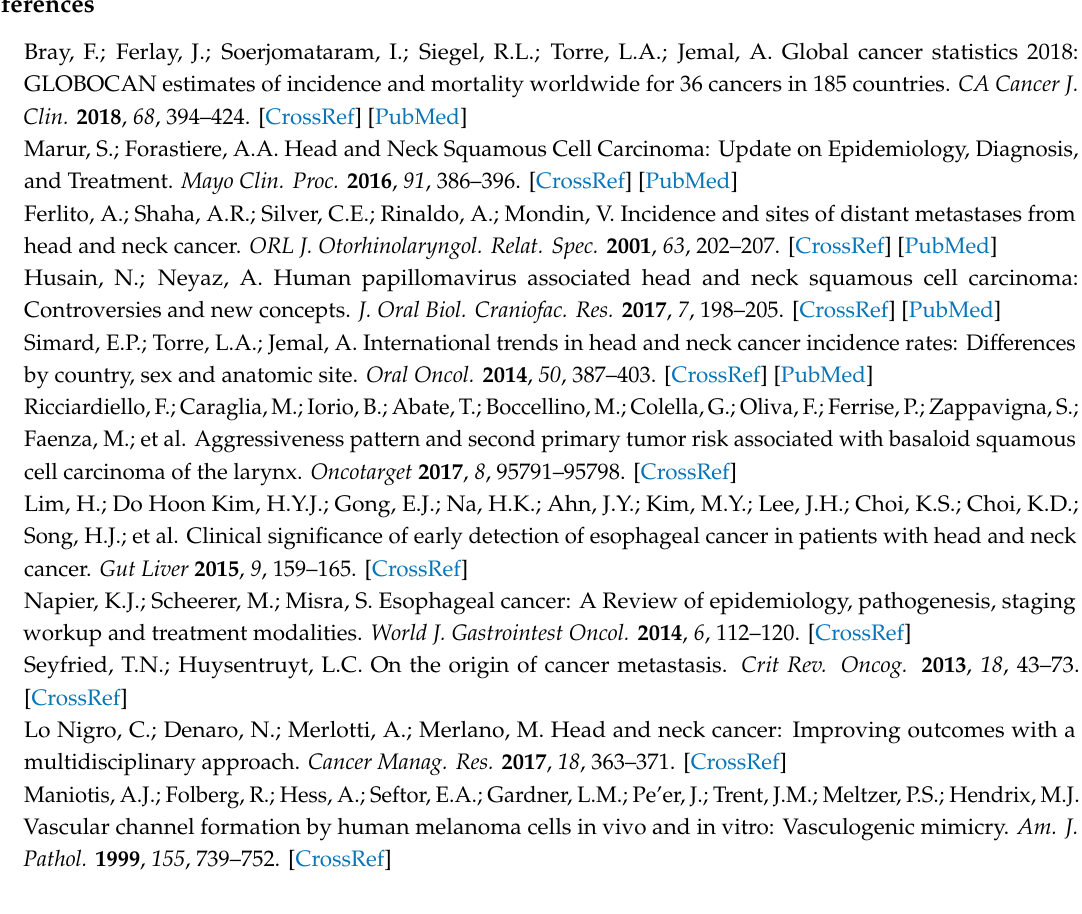
Table S1: Evaluation criteria used to assess the quality of the included studies, Table S2: Analysis of the risk of bias of the included